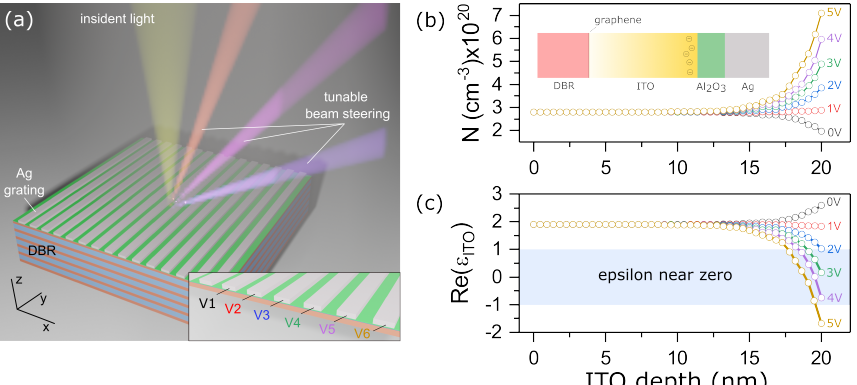
Figure 1. ( a ) Sketch view of the structure; ( b , c ) electron concentration N and real part of the dielectric permittivity Re ε ITO of the ITO layer for different applied bias voltage. The DBR layers’ thicknesses are d a = 165 nm and d b = 135 nm, for silica and titanium dioxide, correspondingly. The number of DBR layers are equal to 15. The 2D array with thickness h = 95 nm and width L = 470 nm has infinite length along the y axis. The pitch of the array p = 500 nm. The ITO and Al 2 O 3 layer thicknesses are 20 nm and 5 nm, respectively. The structure in the inset of Figure 1b is presented schematically to demonstrate the non-uniform distribution of charges in the ITO in the case of applying a bias voltage between Ag nanostripes and monolayer